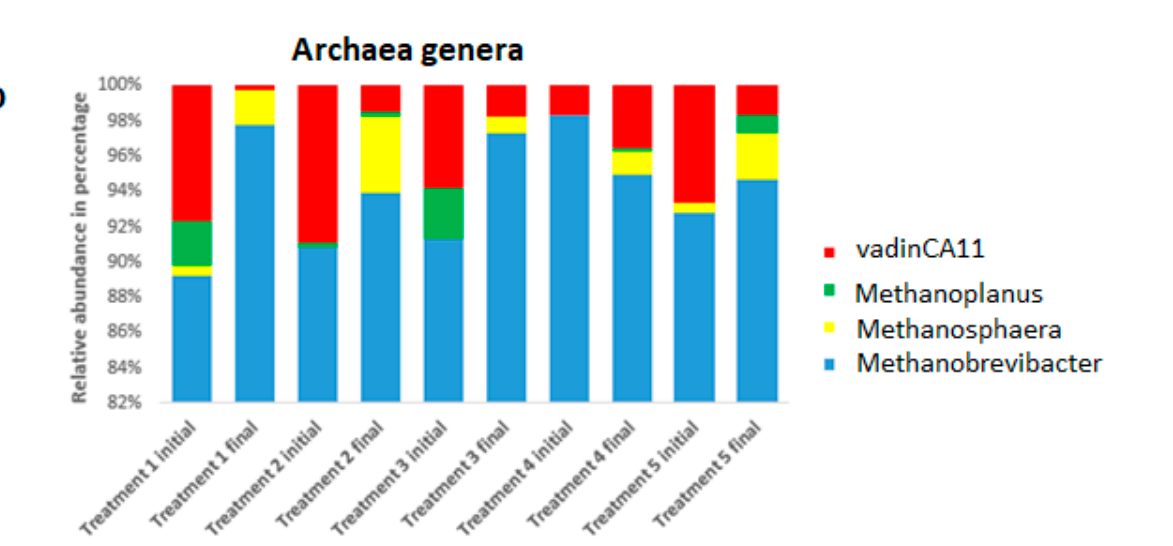
Figure 3. Relative abundance of microbial communities across the five treatment groups of the trial at ( A ) phylum, ( B ) genus, ( C ) species levels. The abundance at genus level was also shown ( D ). “Remainder” includes all phyla or genera with less than 1% relative abundance. T1–T18 indicate samples collected at the beginning of the trial and T19–T36 were collected at the end of the trial. Each bar represents the average relative abundance of each bacterial or archaeal taxon within a group.